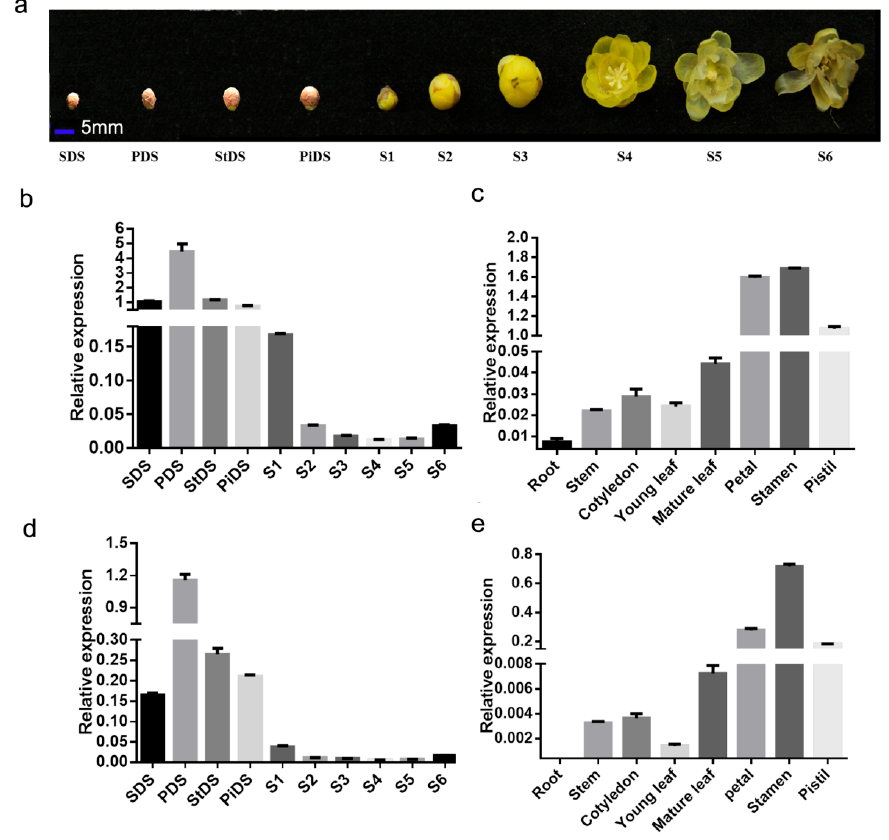
Figure 4. Expression patterns of CpCZF1 and CpCZF2 in different flower developmental stages. ( a ) Flower developmental stages. The transcriptional levels of CpCZF1 ( b ) and CpCZF2 ( d ) in flower buds (flowers) in the process of flower development. Relative expression of CpCZF1 ( c ) and CpCZF2 ( e ) in the tissues of wintersweet. SDS, sepal primordia differentiation stage; PDS, Petal primordia differentiation stage; PiDS, pistil primordia differentiation stage; StDS, stamen primordia differentiation stage; S1–S6, Stage1–Stage 6. Data were expressed relative to CpActin and CpTublin that served as the internal controls; the error bars represent the standard deviation per triplicate.